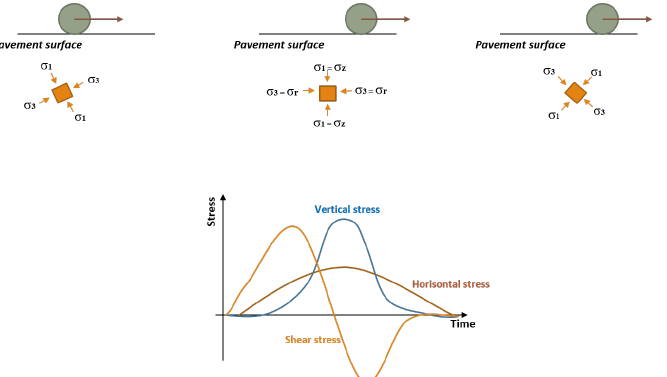
Figure 4. Stress regime in a soil element due to a single moving wheel load. Adapted with permission from [25]. 2021 Fredrick Lekarp.